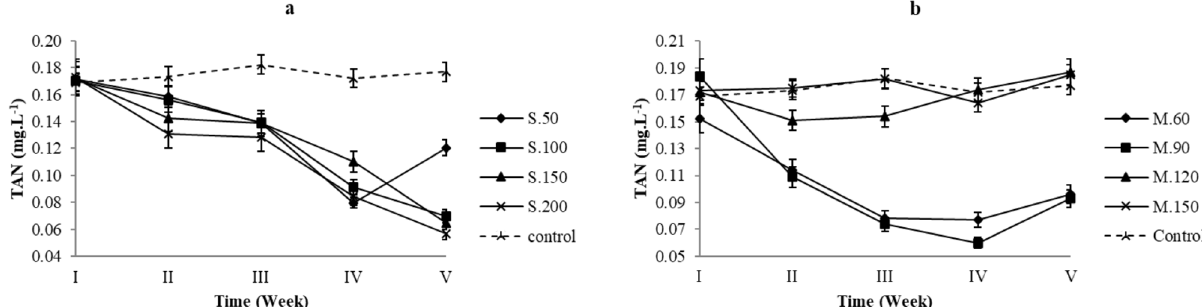
Fig. 4. Concentration dynamics of TAN (mg L (cid:1) 1 ) in the control and at four densities of G. verucosa (a) and P. viridis (b).